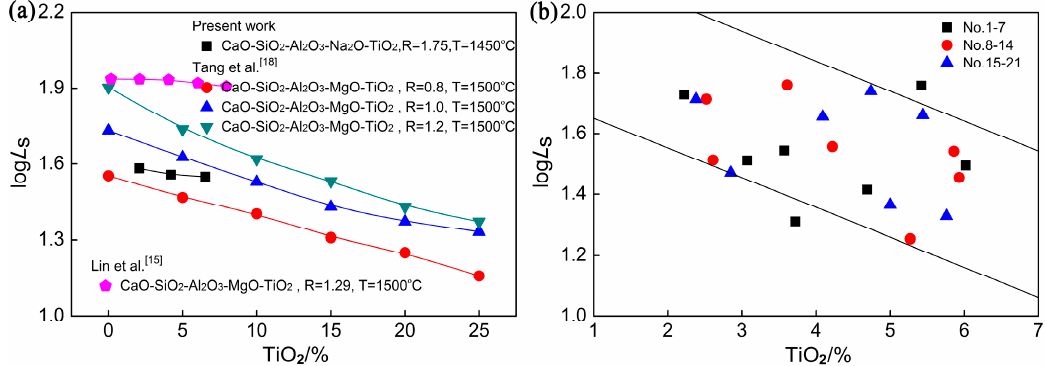
Figure 8. Effect of TiO 2 on log L S .